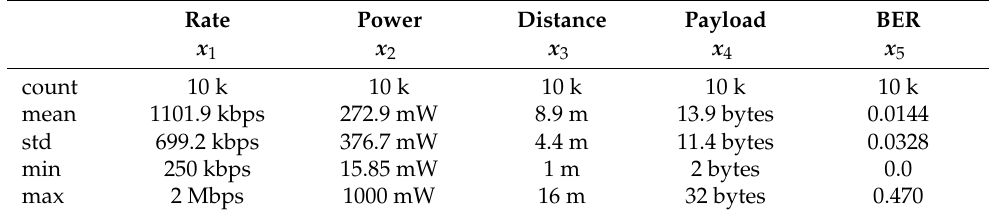
Table 1. Statistical information of the input